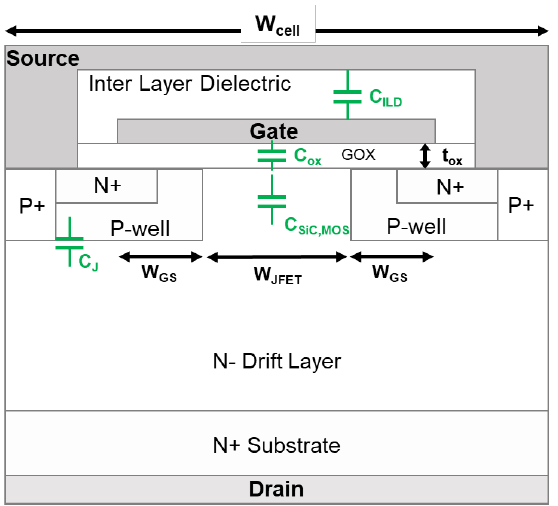
Figure 7. Device capacitance